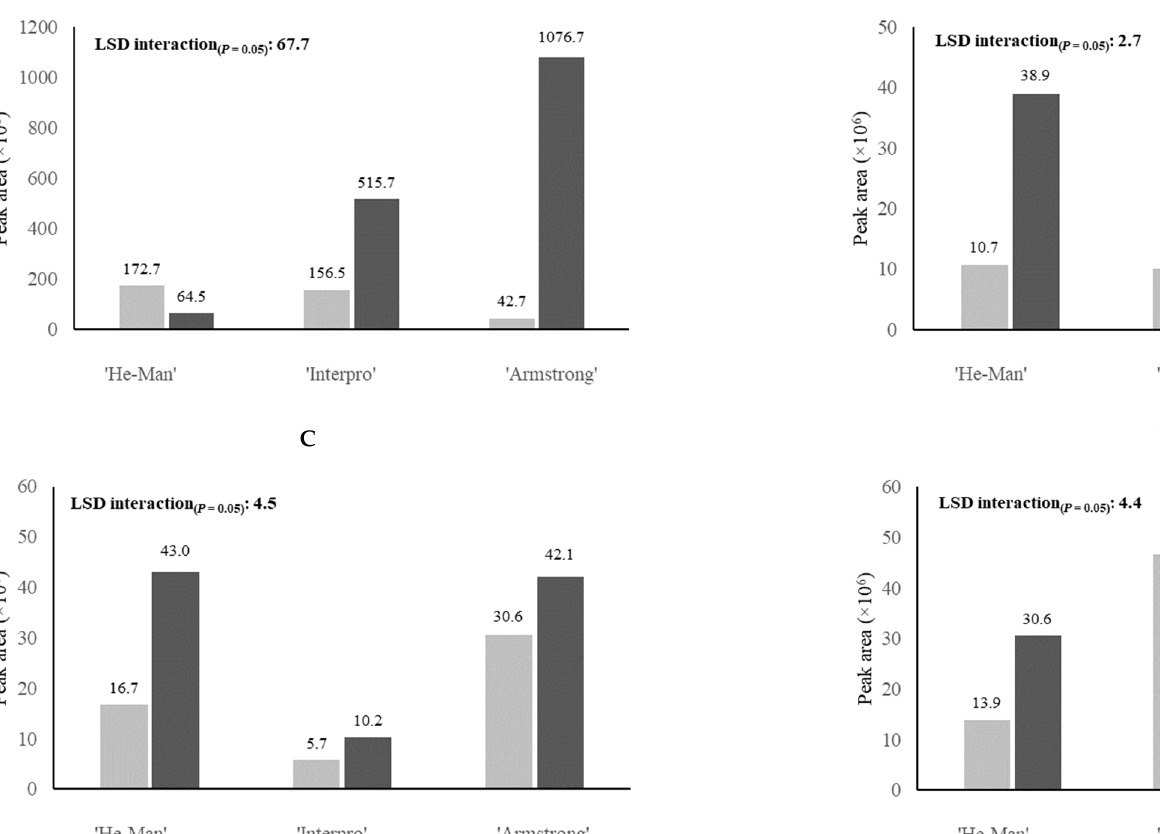
Figure 1. Peak area ( × 10 6 ) of 3-methyl-1-butanol ( A ), 1-pentanol ( B ), 1-hexanol ( C ), and 3-hexen-1-ol ( D ) in tomatoes “Sir Elyan” as a ff ected by ‘rootstock × ripening stage’ interaction. Light bars: S 1 . Dark bars: S 2 .